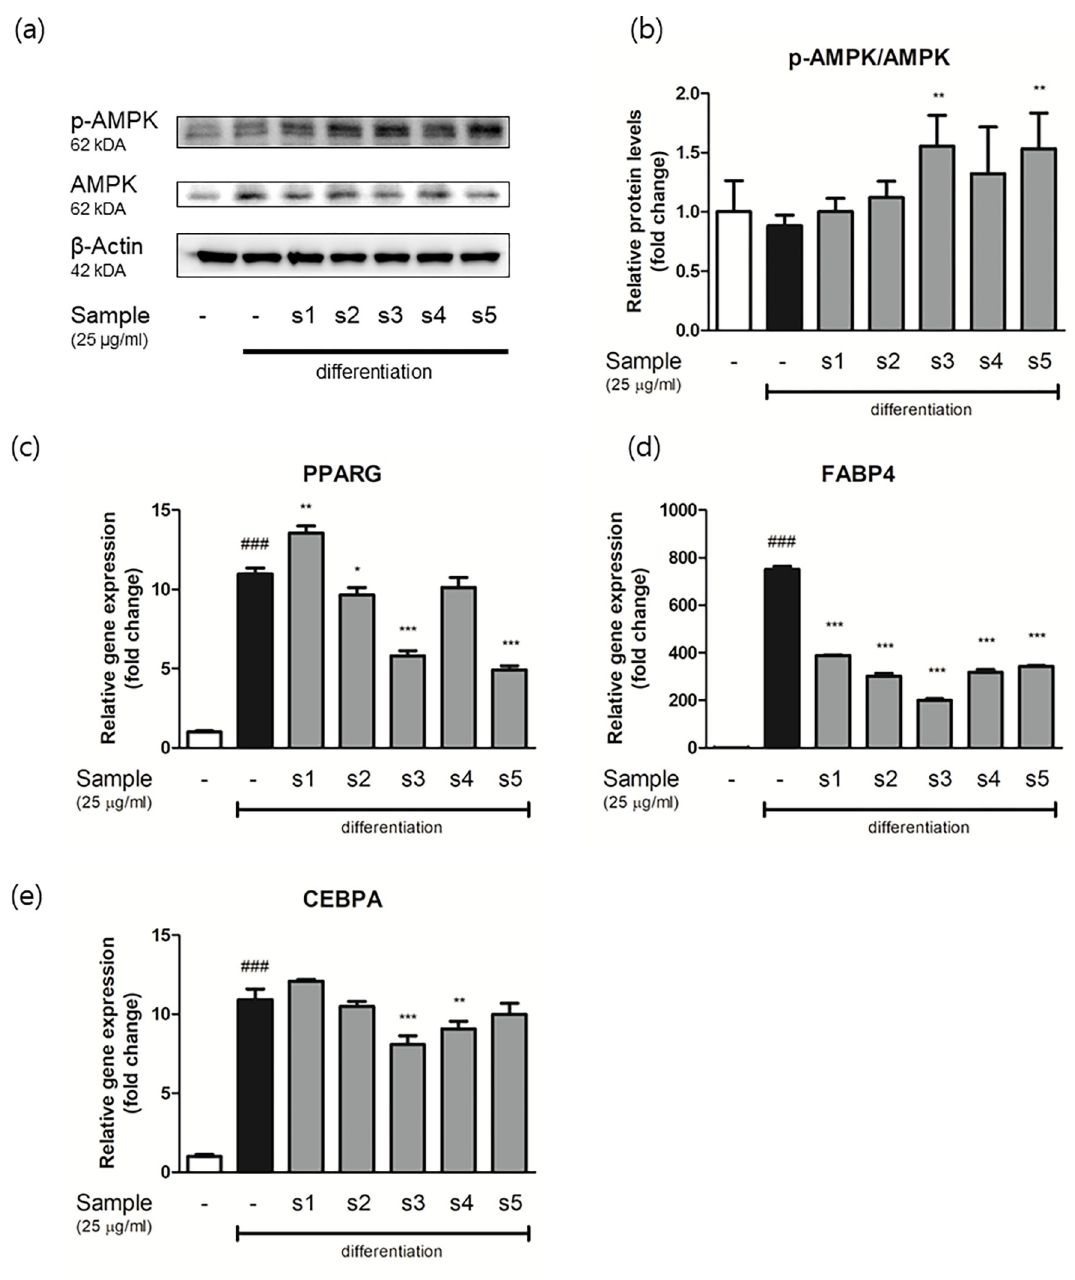
Fig 8. Relative protein and gene expression levels of adipocytes differentiation markers as determined by western blot and real- time quantitative PCR in adipocytes. (a) Representative blot of p-AMPK and AMPK. (b) Band intensities were measured densitometrically and divided by that of non-phosphorylated AMPK. Real-time quantitative PCR results for (c) PPAR gamma, (d) FABP4, and (e) C/EBPa. Relative gene expressions were calculated by dividing each Ct value by that of β -actin. Results are presented as the means ± SDs of three different experiments. ###P < 0.001 versus preadipocytes, and � P < 0.05, �� P < 0.01, and ��� P < 0.001 versus differentiated